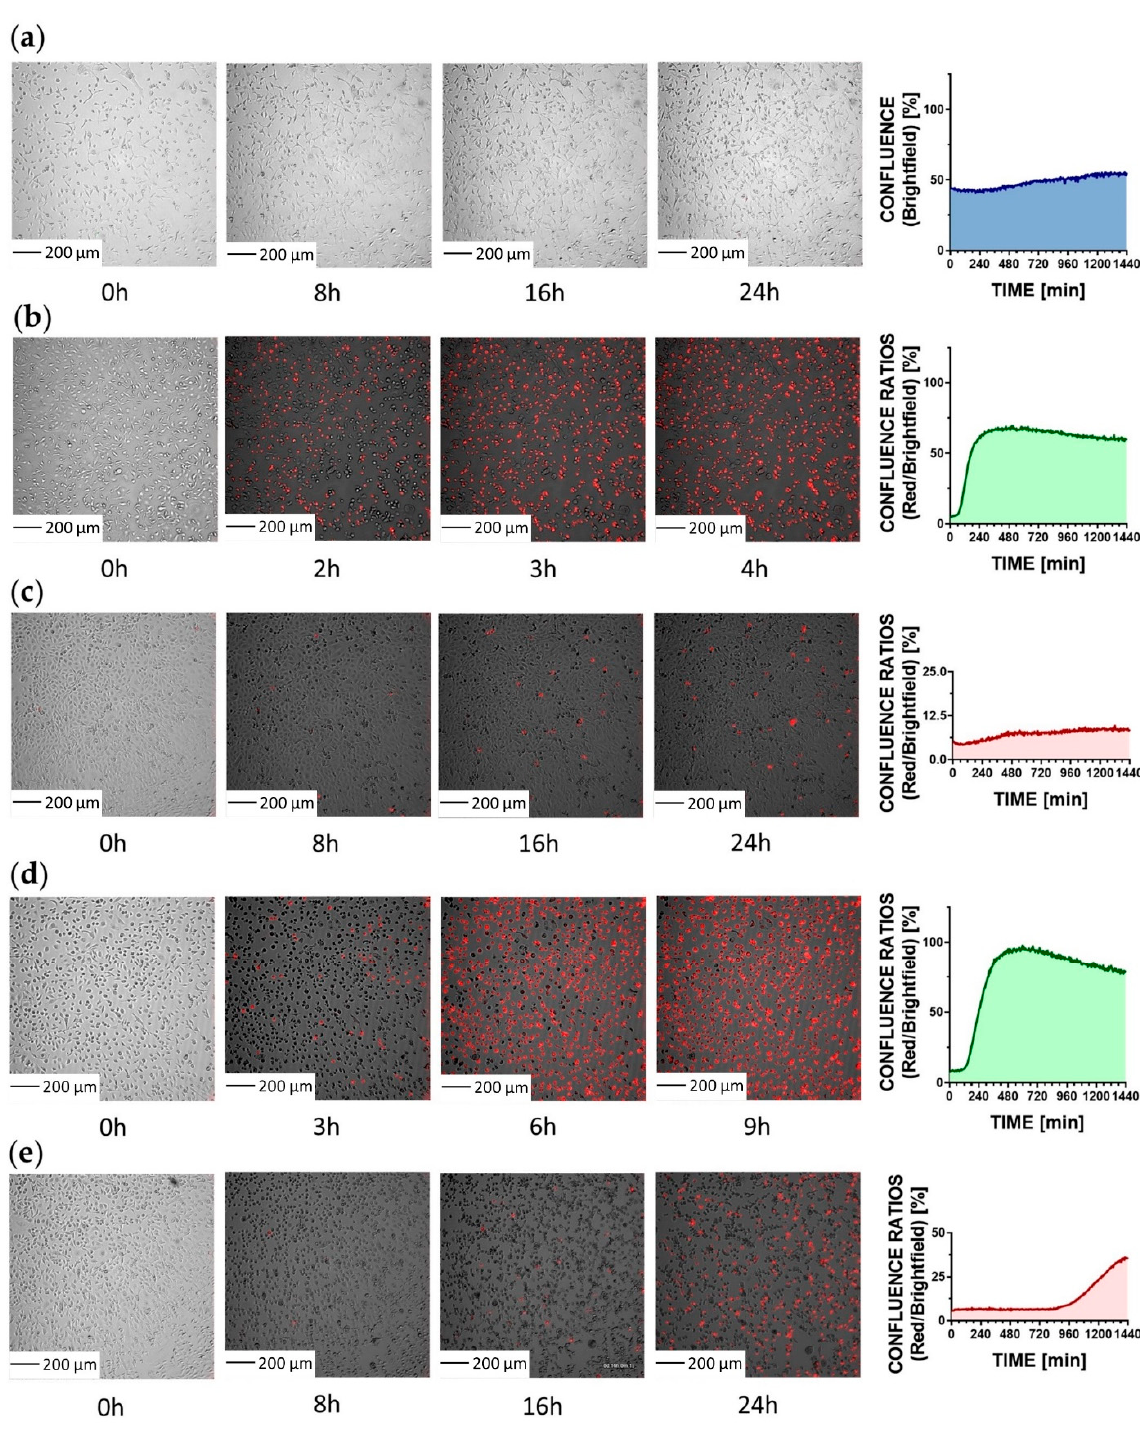
Figure 5. Real-time fluorescence microscopy. Snapshots are presented with the red channel enabled to visualize late apoptotic/necrotic cells. ( a ) Control cells snapshots—cells were treated with propidium iodide (PI) and registered with brightfield, green, and red channels enabled. The graph shows the confluence of cells. ( b ) MDA-MB-231 cells treated with PI and 25 µ M curcumin and registered with brightfield, green, and red channels at the same time. The graph shows confluence ratios for red/brightfield channels; ( c ) MDA-MB-231 treated with PI and 25 µ M curcumin and registered with the brightfield and red channels enabled. The graph shows confluence ratios for red/brightfield channels; ( d ) MDA-MB-231 cells treated with PI and 25 µ M compound 5 and registered brightfield, green, and red channels enabled at the same time. The graph shows confluence ratios for red/brightfield channels. ( e ) MDA-MB-231 treated with PI and 25 µ M compound 5 and registered with the brightfield and red channels enabled. The graph shows confluence ratios for red/brightfield